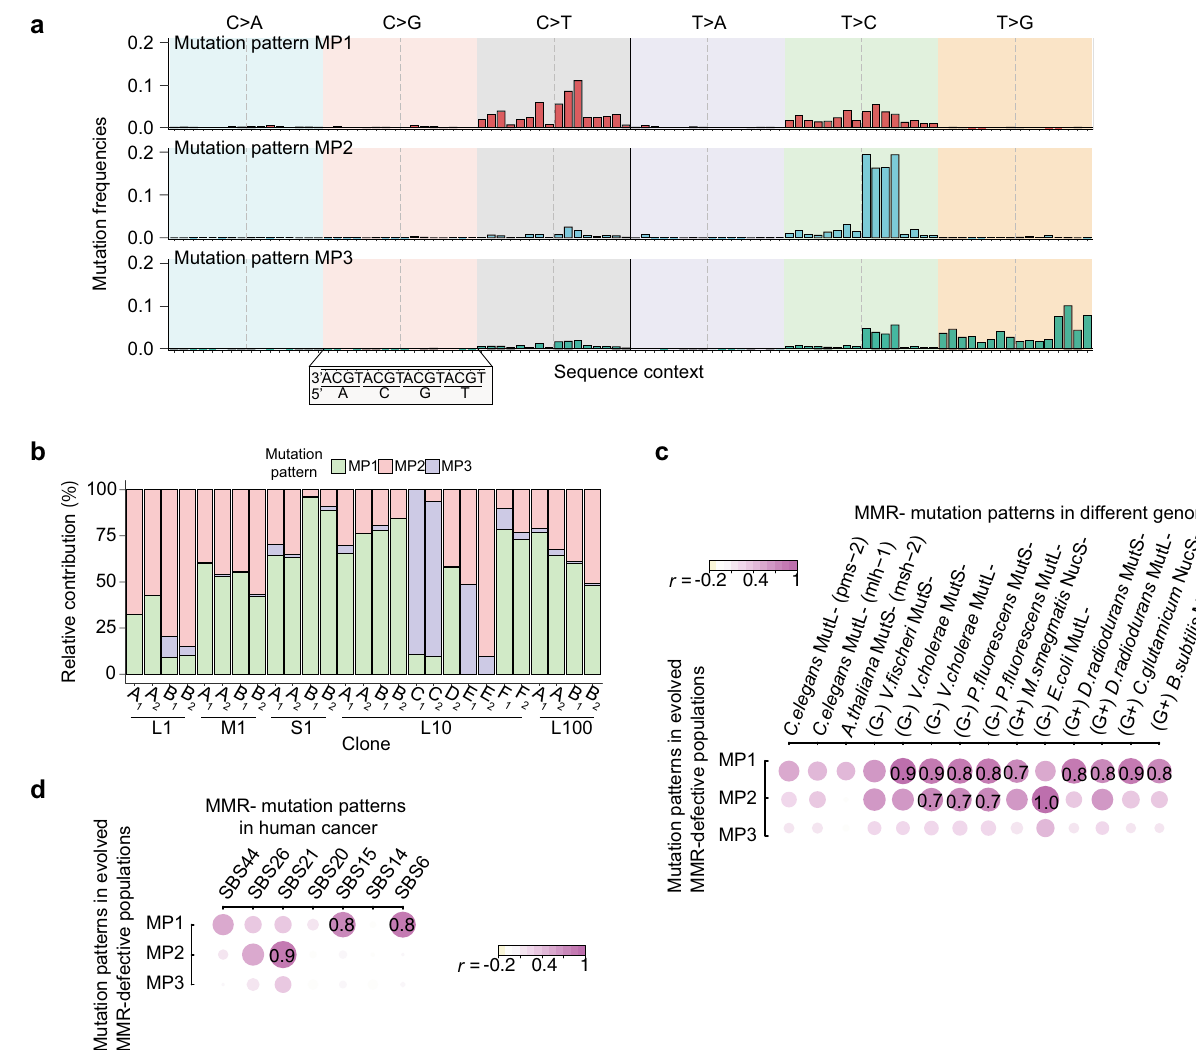
Fig. 4 | Mutation patterns for MMR- populations. a The 96-class contextual mutational spectra for the three mutation patterns (MPs) for the evolved popu- lations with MMR- background or the L10 transfer scheme based on the dimen- sionality reduction analysis. Each bar represents a class; each class represents a single nucleotide change (one of six colored blocks; labels on the top) with the context of 3 ′ and 5 ′ fl anking nucleotide (ticks at the bottom). b Three MPs largely contribute to the mutation pro fi les of clones isolated from the evolved popula- tions with MMR- background or the L10 transfer scheme. c Correlation